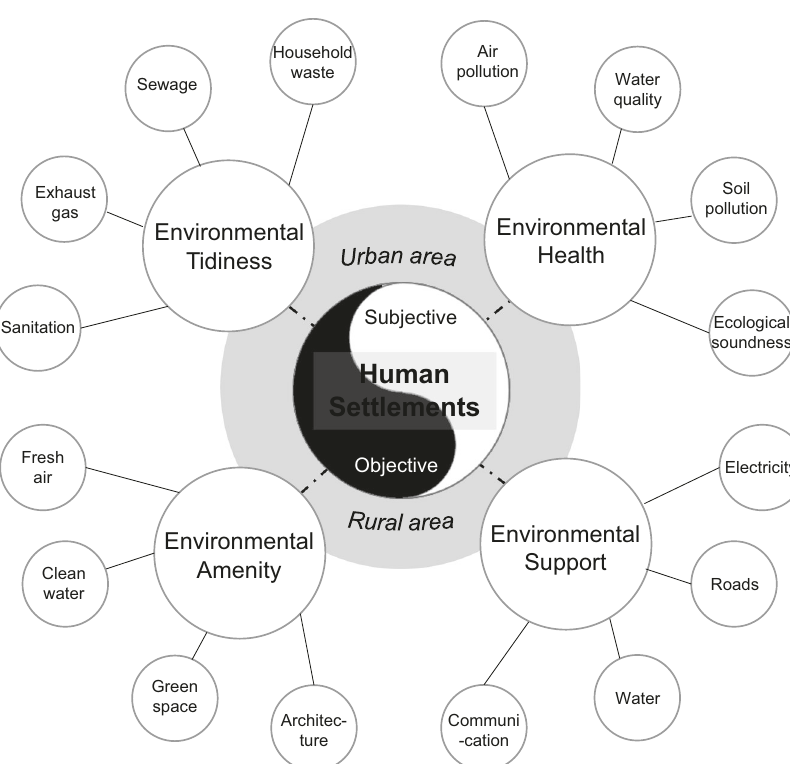
Fig. 1 Theoretical framework of the comprehensive evaluation of urban – rural human settlements. Among the four dimensions, environmental tidiness is closely related to the treatment of sewage, household waste, and exhaust gas. Environmental health is connected with the quality and pollution status of water, air, and soil. Environmental amenities puts forward demands on suf fi cient green space, clean water, and fresh air. Environmental support is mainly represented by the infrastructure